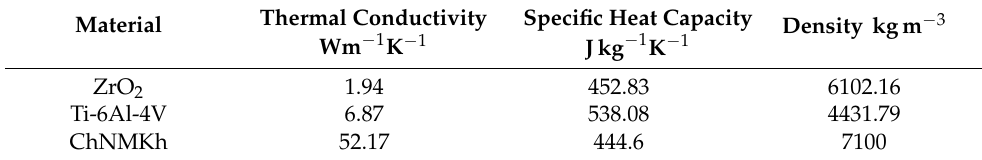
Table 1. Material properties at the initial temperature T 0 [3,13].